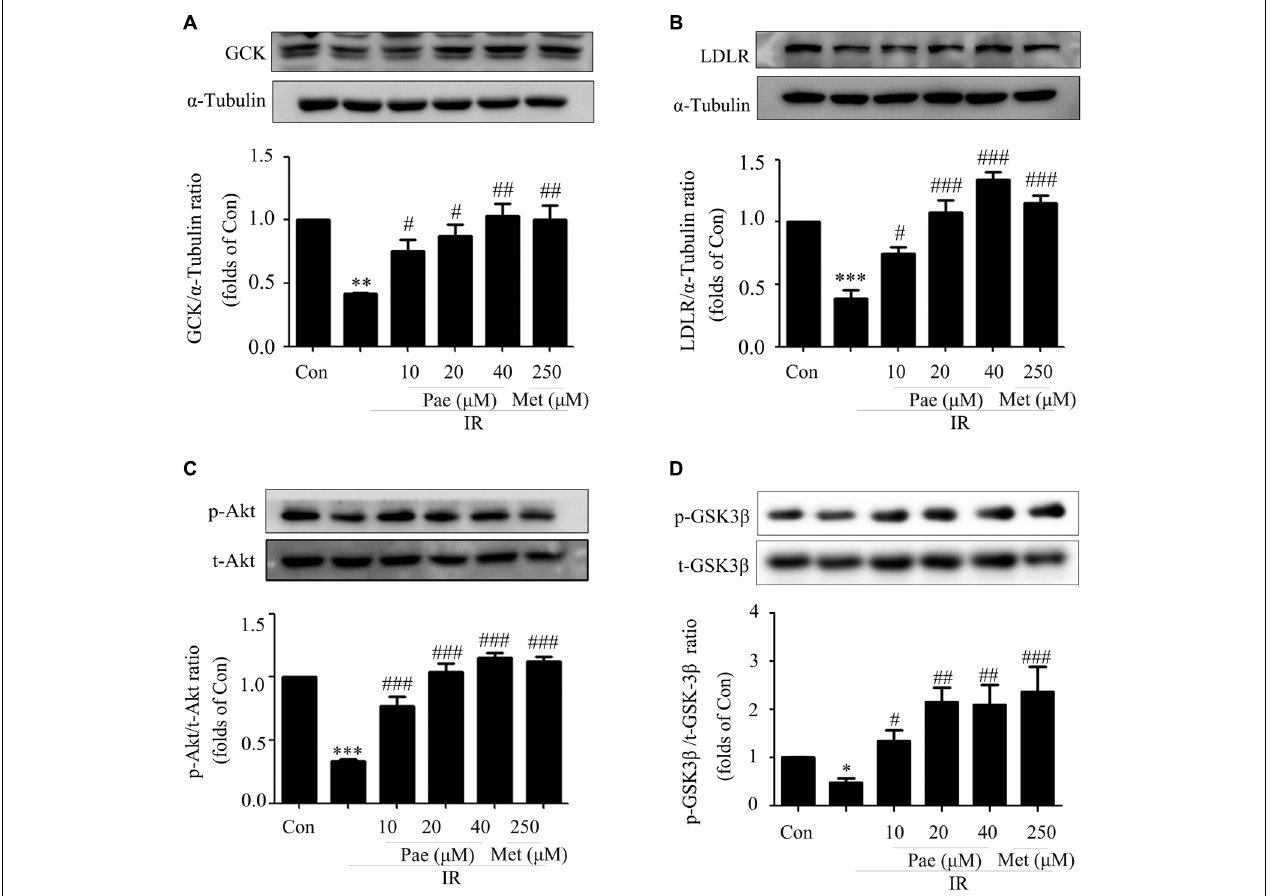
FIGURE 4 | Paeonol regulated the phosphorylation of Akt and the protein contents of GCK and LDLR in insulin-resistant HepG2 cells. (A,B) GCK and LDLR expression levels induced by paeonol under IR. (C) Akt phosphorylation level in HepG2 cells. (D) p-GSK-3 β content measured by western blot. All experiments were performed at least three times with similar results. ∗ p < 0.05, ∗∗ p < 0.01, and ∗∗∗ p < 0.001 vs. Con; # p < 0.01, ## p < 0.01, and ### p < 0.001 vs.